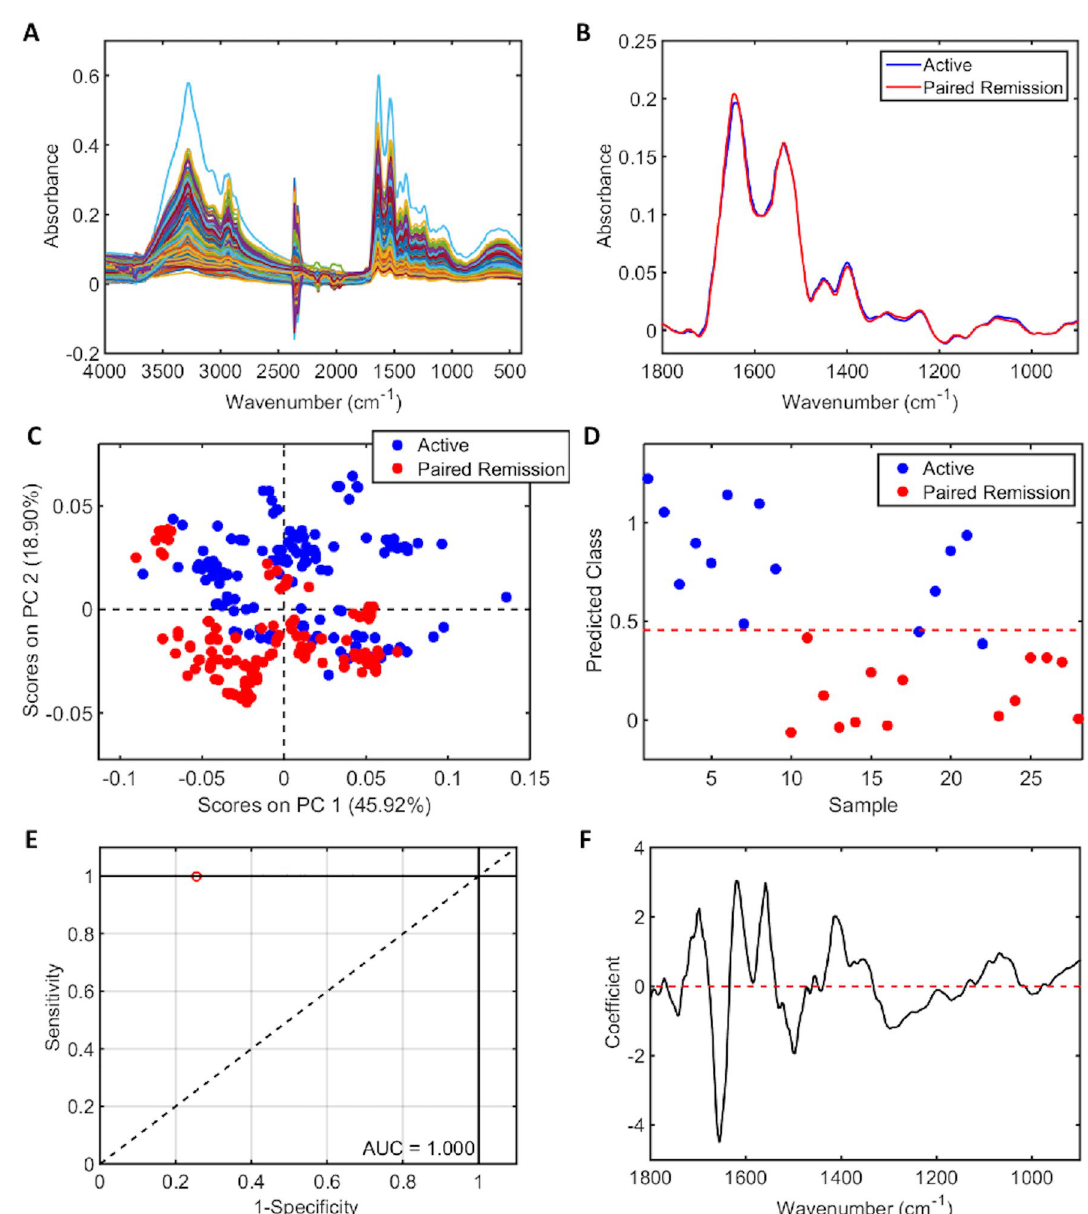
Figure 2. ATR-FTIR spectral classification of active disease vs. paired remission for plasma samples following successful remission induction therapy—( A ) Raw spectral data, ( B ) Pre-processed spectra, ( C ) PCA scores plot, ( D ) PLS-DA discriminant function graph, ( E ) ROC curve for PLS-DA, ( F ) PLS-DA coefficients for identification of spectral